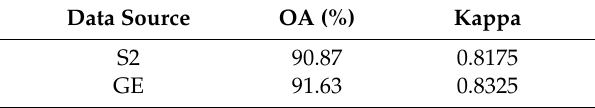
Table 7. Comparison with Sentinel-2 data.